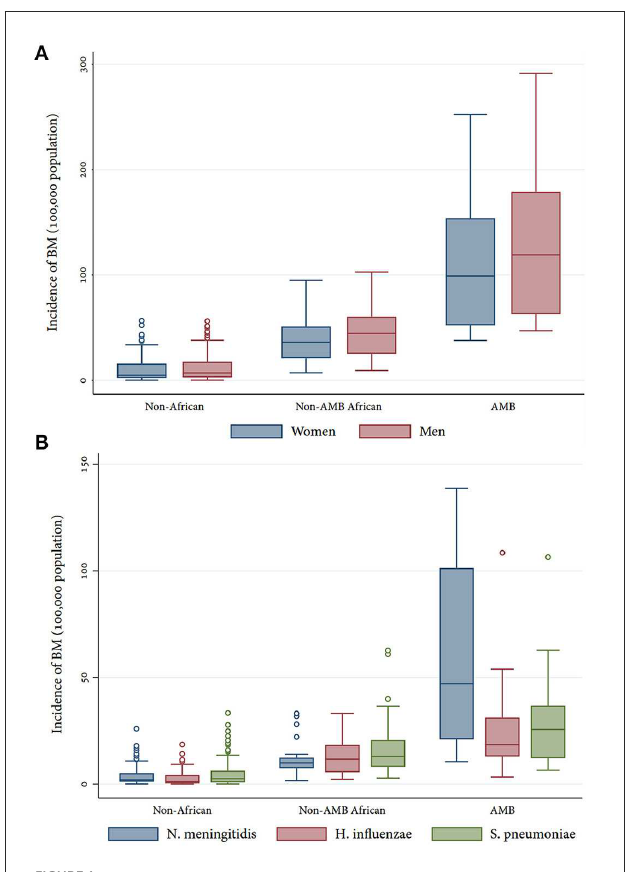
FIGURE1 Incidence of BM by sex (A) and etiological agent (B) per